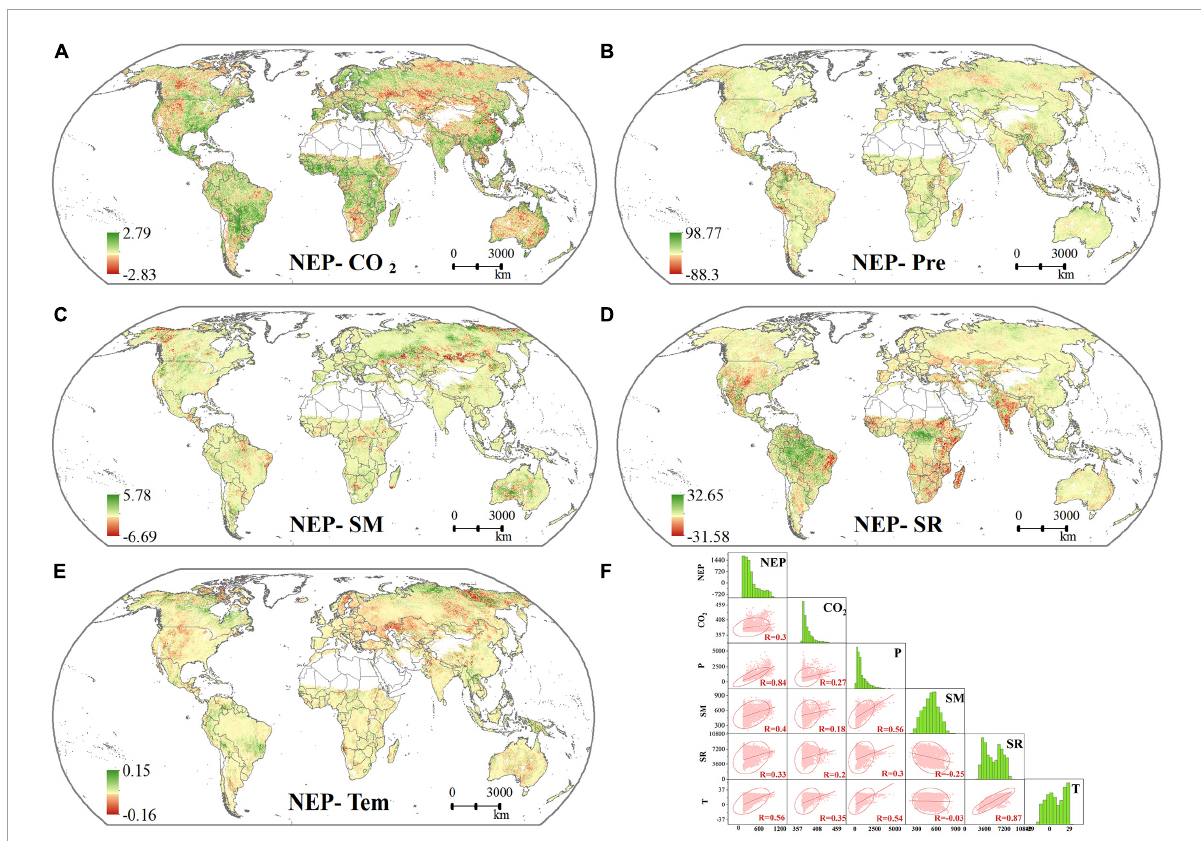
FIGURE2 Sensitivity of NEP to climate factor. Sensitivity of NEP to changes in CO 2 concentration (A) , P (B) , SM (C) , SR (D) , and T (E) ; correlation analysis between NEP and climate factors (F)